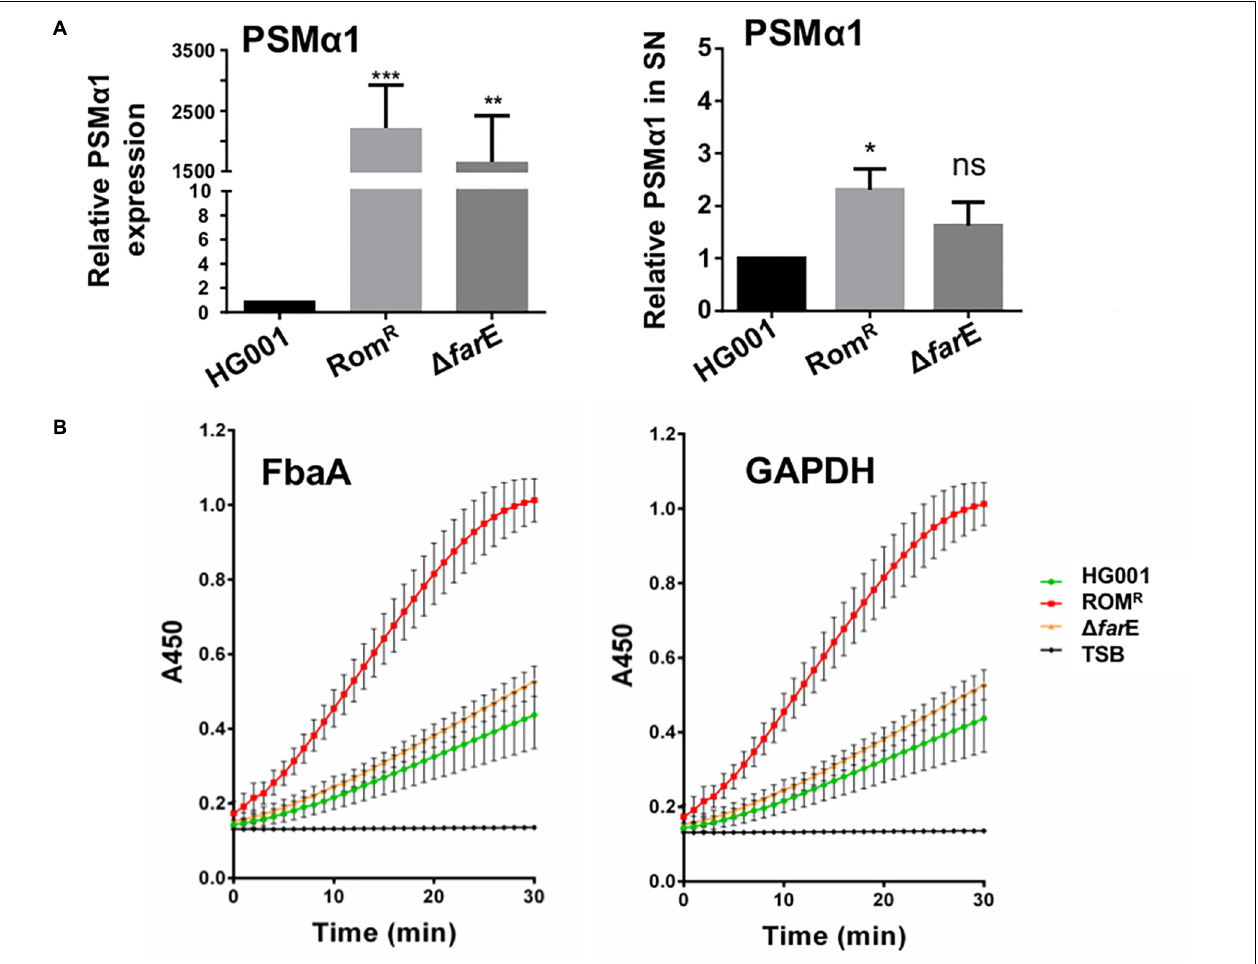
FIGURE 3 | Comparison of release of PSM α and the cytoplasmic proteins FbaA and GAPDH. (A) (Right) PSM α 1 expression of HG001, Rom R and (cid:49) farE (Rom R (cid:49) farE ) were determined by Real-Time PCR. The strains were aerobically cultured in TSB medium for 16 h. The pellets were used for total RNA extraction. qPCR experiments were carried out to determinate psm α 1 and gyrB was used as housekeeping gene. Fold changes were calculated using (cid:49)(cid:49) Ct method and relativized to the HG001 expression. Error bars indicate standard error. Statistical significances between mutant clones Rom R , (cid:49) farE (Rom R (cid:49) farE ) with the wild type HG001 were analyzed by 1-way ANOVA: not significant P > 0.05, ∗ P < 0.05, ∗∗ P < 0.01, ∗∗∗ P < 0.001. (Left) Release of PSM α 1 into the supernatant of HG001, Rom R clone and Rom R (cid:49) farE cultured in TSB for 16 h was determined by HPLC; the relative amount of PSM α was calculated by comparing the peak-area in the samples. All experiments were performed in triplicate. Error bars indicate standard error. Statistical significances between mutant clones Rom R , (cid:49) farE (Rom R (cid:49) farE ) with the wild type HG001 were analyzed by Student t -test: not significant P > 0.05, ∗ P < 0.05, ∗∗ P < 0.01, ∗∗∗ P < 0.001. (B) Comparative release of